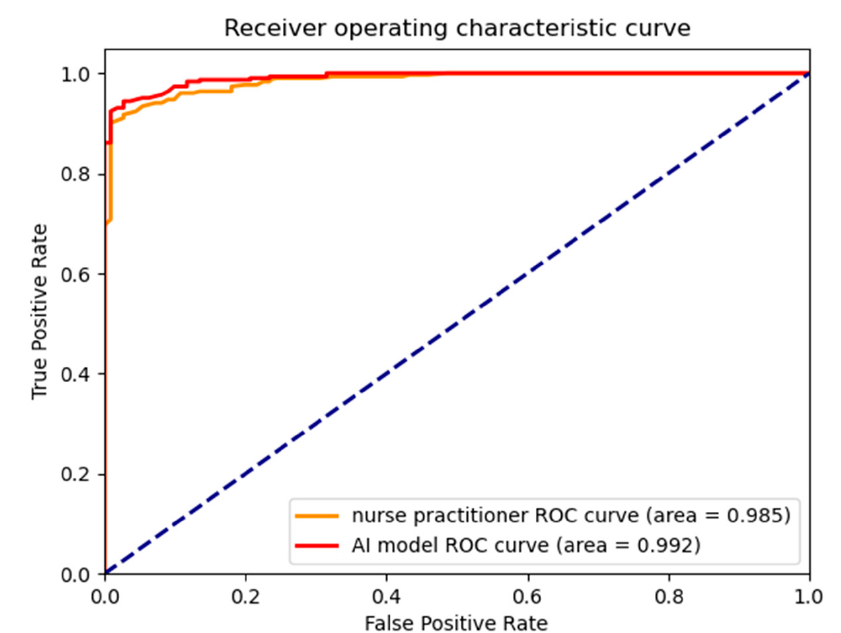
Figure 2. ROC curves and AUCs in the detection of cardiomegaly (CTR > 50% as calculated by the nephrologists) according to automated and manual CTR calculations.